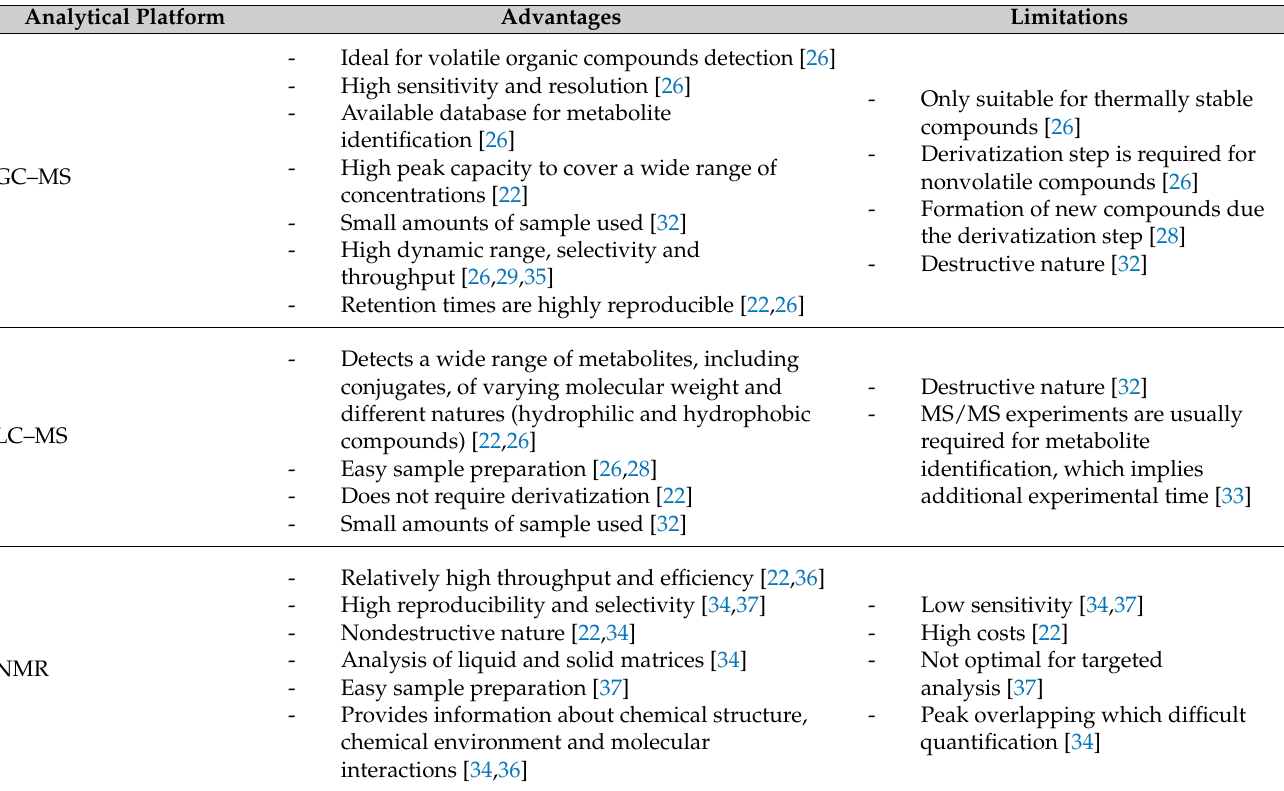
Table 1. Main advantages and limitations of gas or liquid chromatography coupled with mass spectrometry (GC–MS or LC–MS), and nuclear magnetic resonance spectroscopy (NMR) in metabolomic